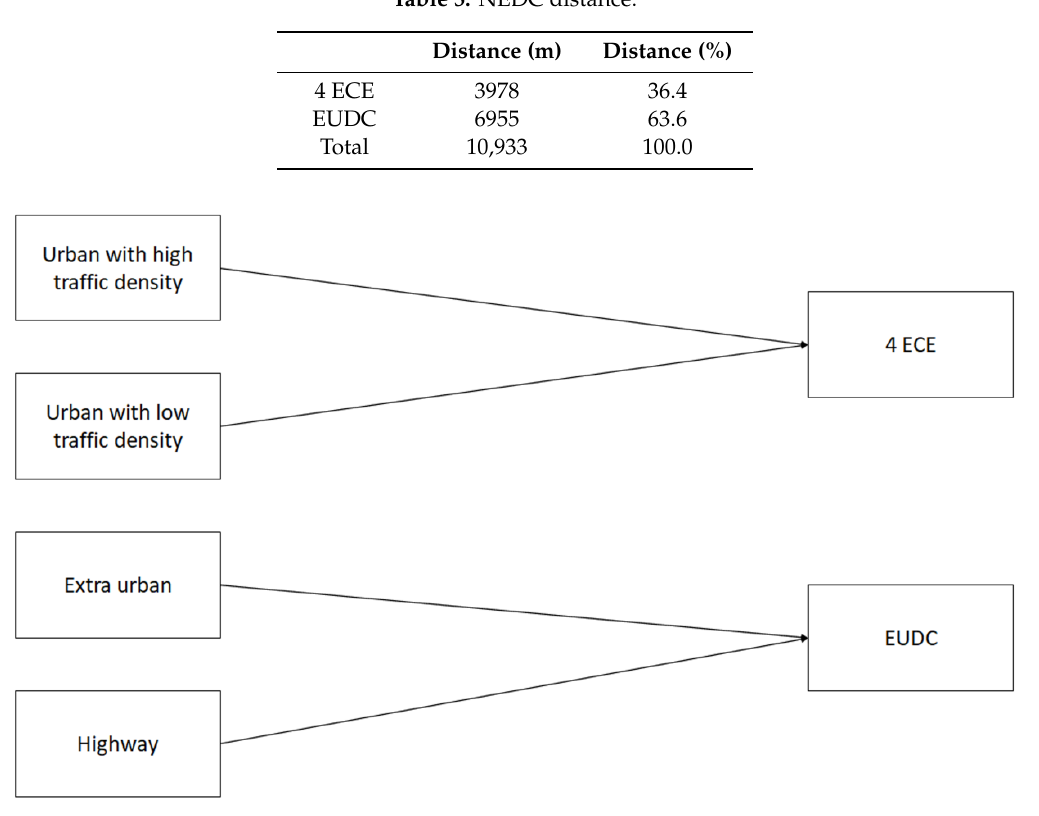
Figure15. Schemeofcalculationofenergyconsumptionintheteststocomparewithenergyconsumption Figure 15. Scheme of calculation of energy consumption in the tests to compare with energy in NEDC (4 ECE, consumption in NEDC (4 ECE, EUDC).